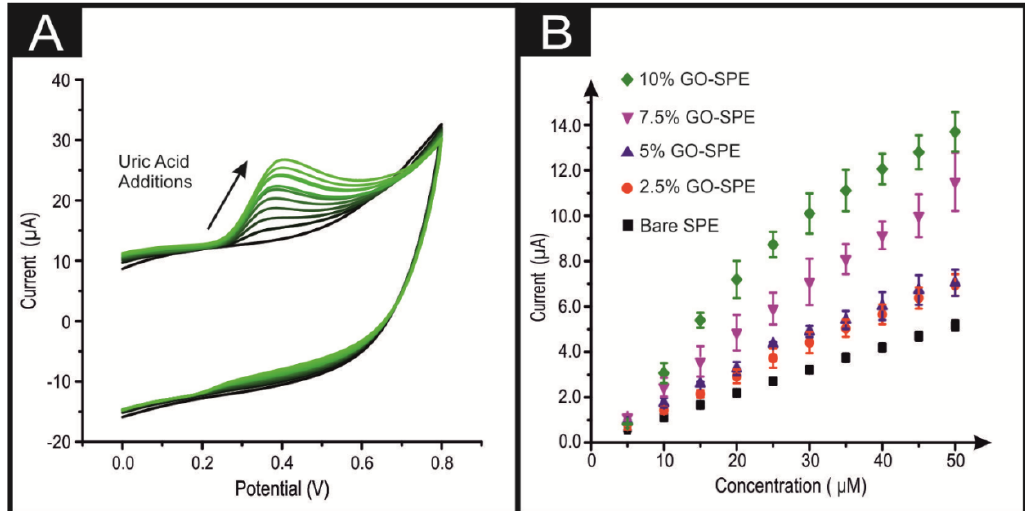
Figure 3. (A) Typical cyclic voltammetric response obtained utilising 10% GO-SPEs by sequentially adding aliquots of UA to pH 7.4 PBS, from 20 to 200 µM. (B) Calibration plot of the anodic peak current associated with the oxidation of UA over the concentration range for a bare SPE (black square), a 2.5% GO-SPE (orange circle), a 5% GO-SPE (blue triangle), a 7.5% GO-SPE (purple inverted triangle), and a 10% GO-SPE (green star). Error bars are on the data points and represent the average standard deviation ( N = 3). Scan rate utilised: 100 mVs –1 (vs. SCE ).